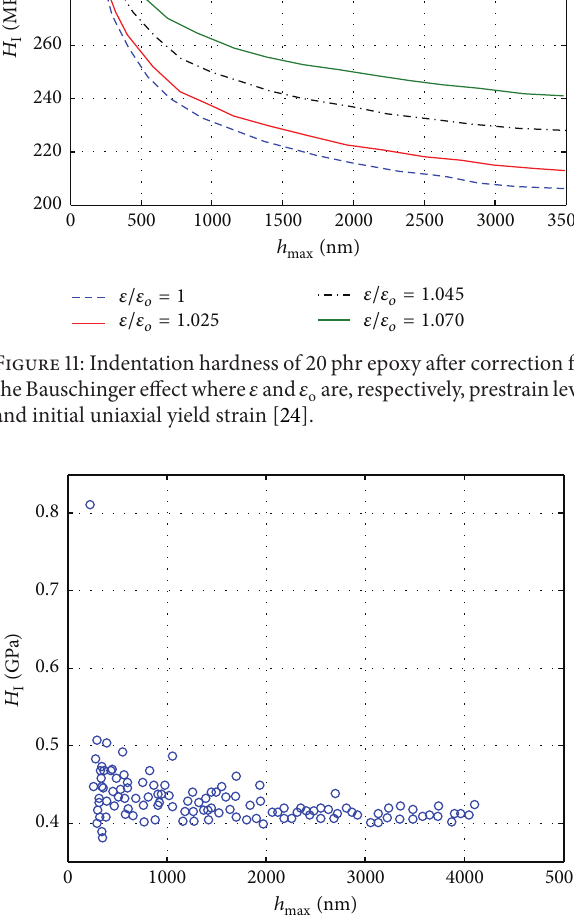
Figure 12: Indentation hardness of PMR-15 polyimide with a Berkovich tip [40].